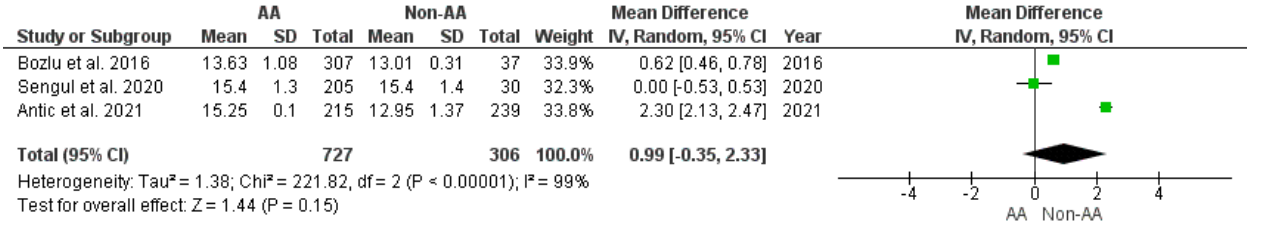
Figure 4. Forest plot comparison between children belonging to the AA versus non-AA groups in terms of the average values of red cell distribution width. Abbreviations: AA—acute appendicitis; non-AA—nonacute appendicitis; IV—inverse variance; and CI—confidence interval.